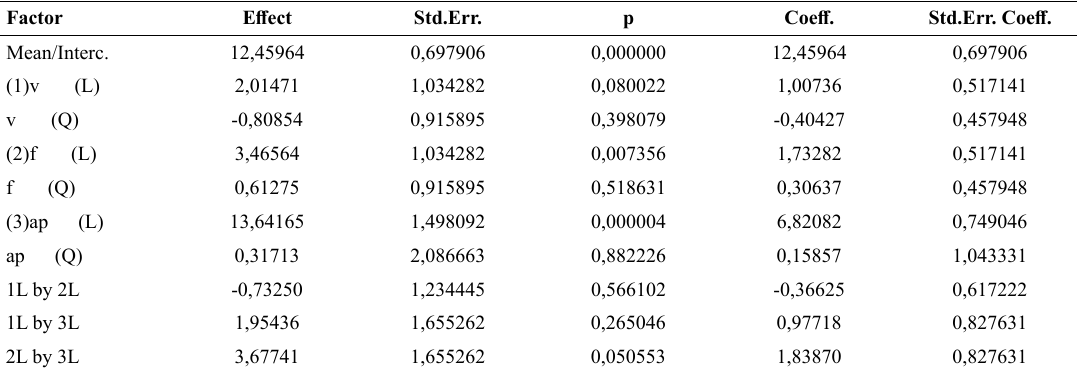
Table 7. ANOVA for the effect of the independent variables on penetration force. Factor Effect Std.Err. p Coeff. Std.Err.